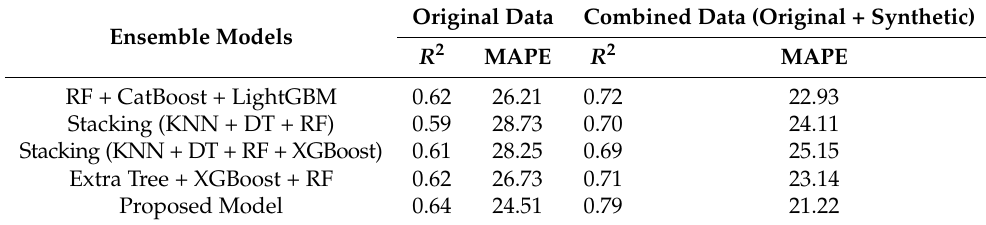
Table 4. Performance comparison with different ensemble approaches.